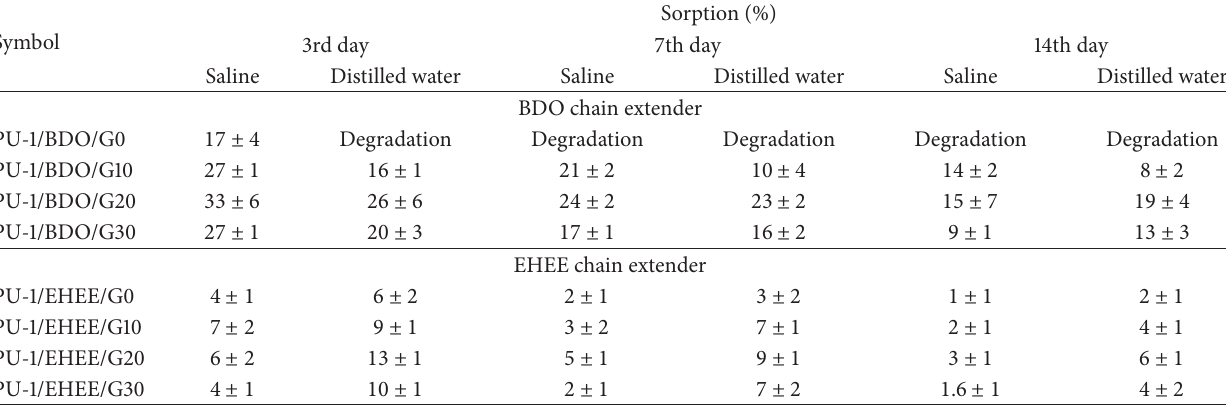
Table 5: Saline and distilled water sorption of PU foams prepared with different chain extenders and various amounts of gelatin. Sorption (%) Symbol 3rd day 7th day Saline Distilled water